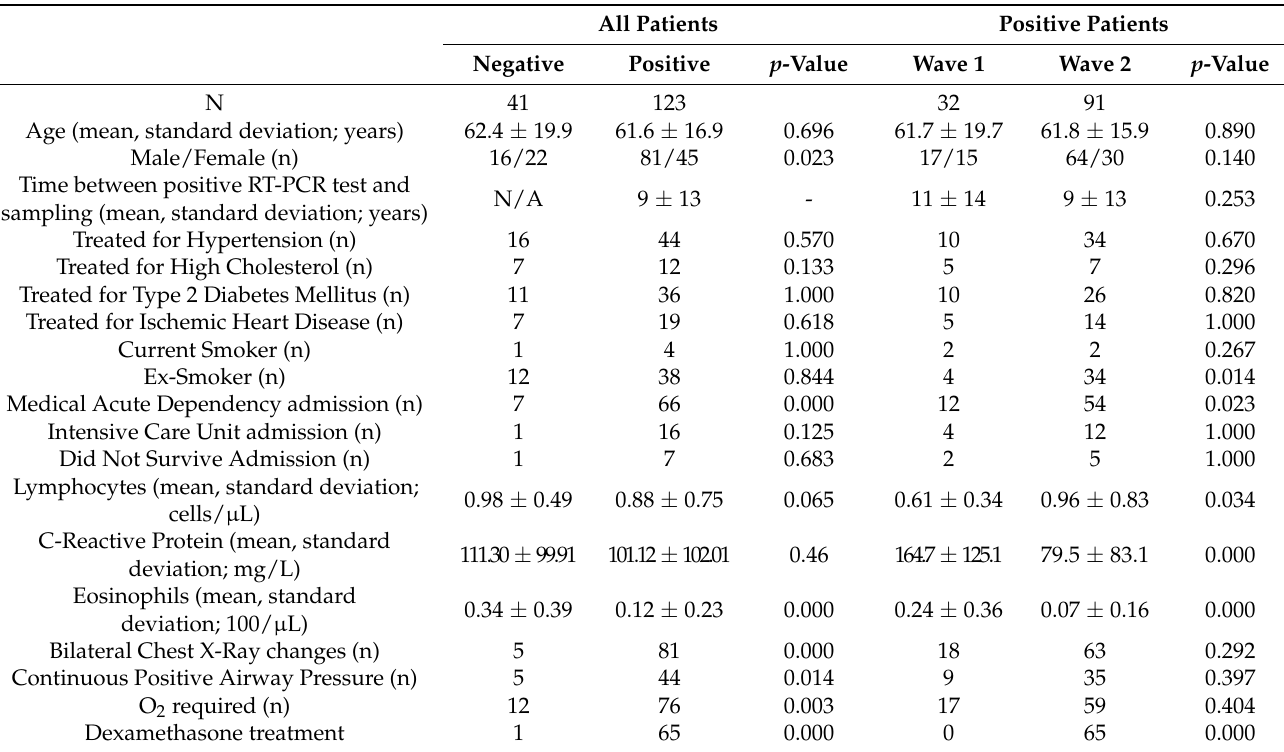
Table 1. A summary of the clinical characteristics comparing positive and negative patients, and Wave 1 and Wave 2 positive patients. All Patients Positive